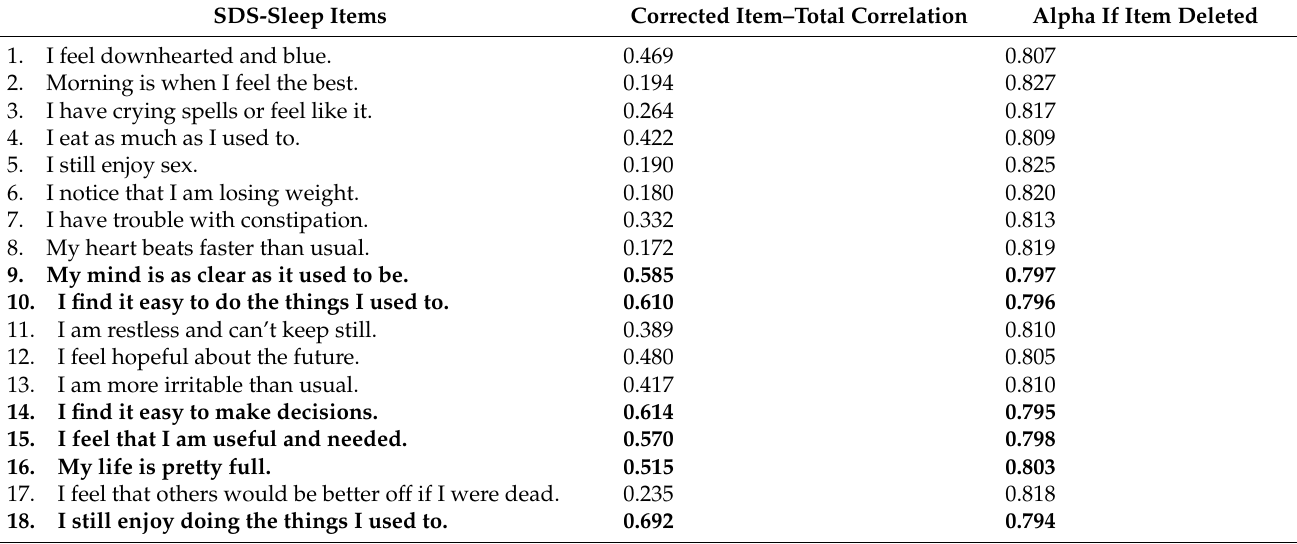
Table 2. Item–total correlations and Cronbach alpha for SDS-Sleep items from 55 patients with PCa (total scale alpha =